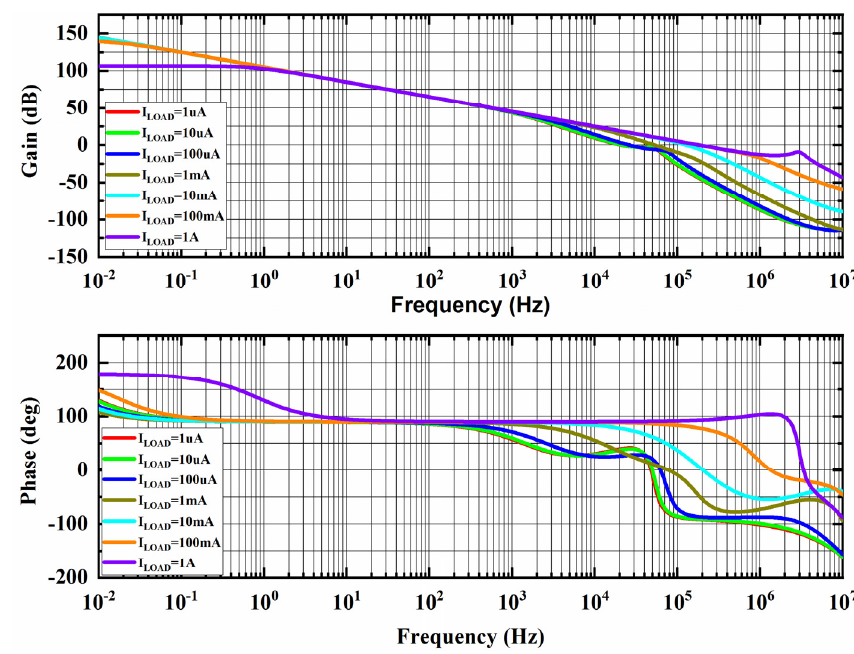
Figure 5. Simulated loop gain of the LDO under different load currents.